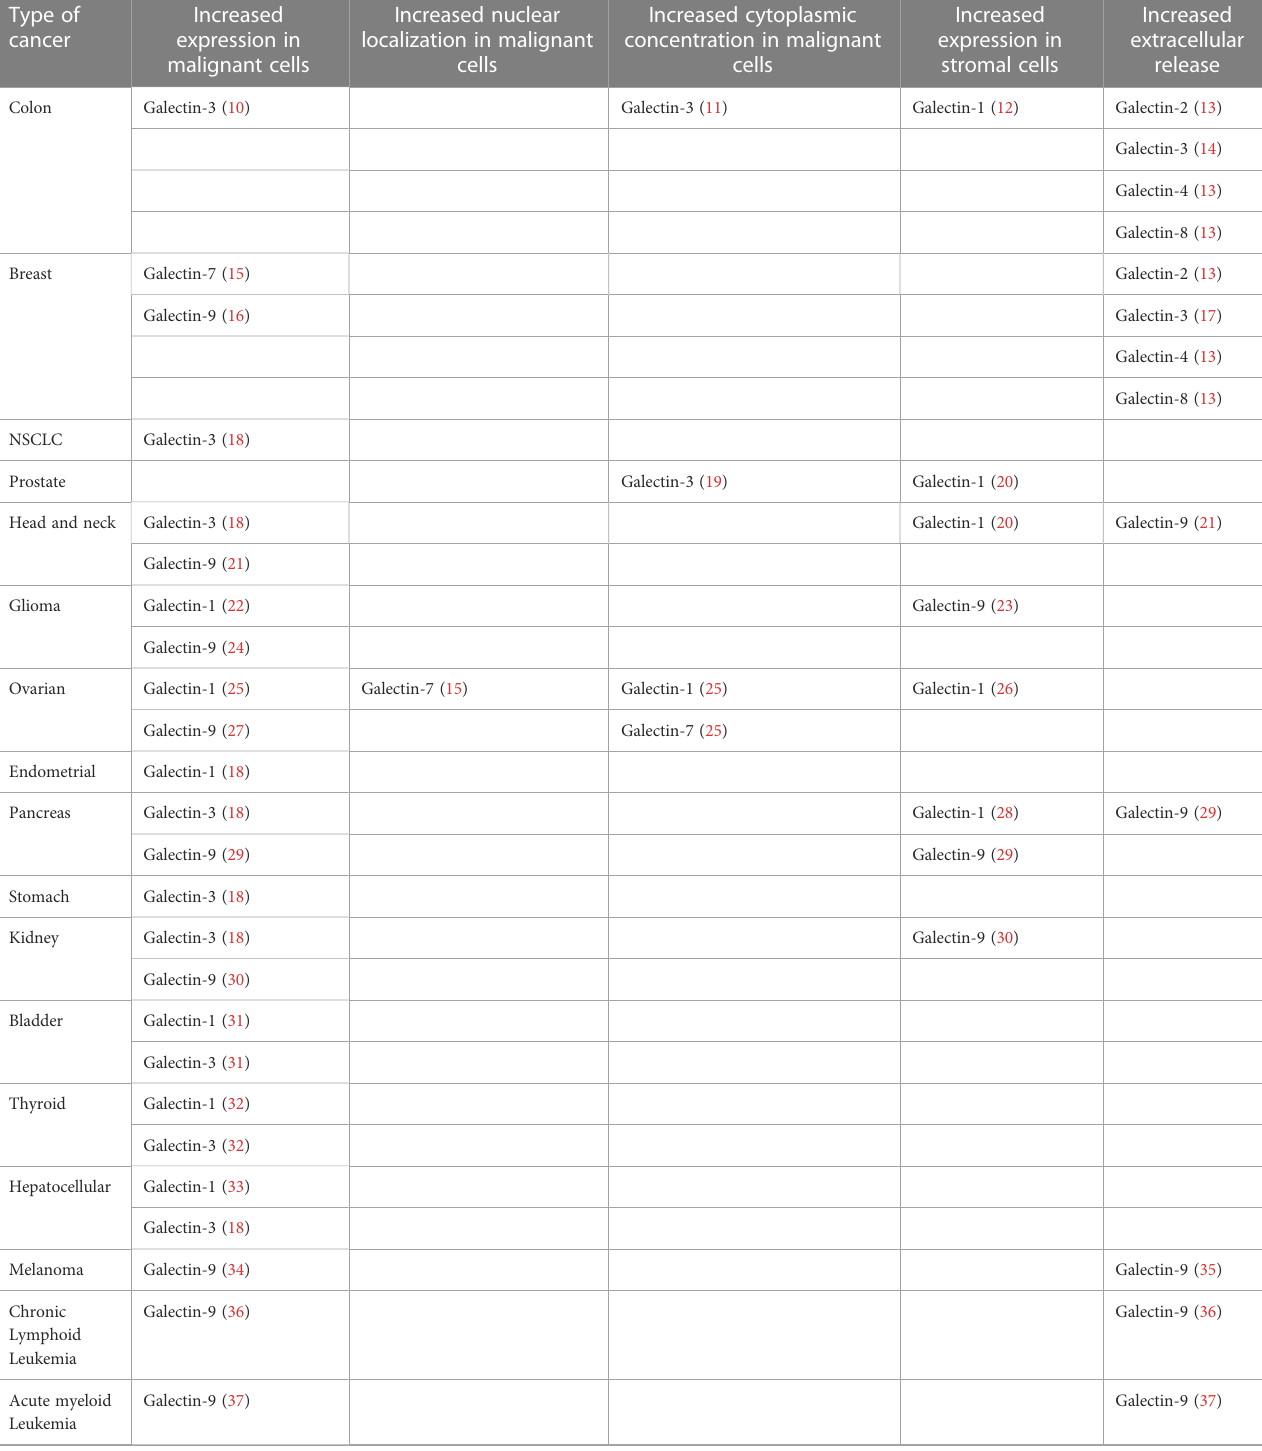
TABLE 1 Classi fi cation of dysregulated galectin phenotypes in cancer, according to cancer type, galectin member, type of dysregulation and impacted compartment of the malignant cell or the tumour microenvironment. Type of